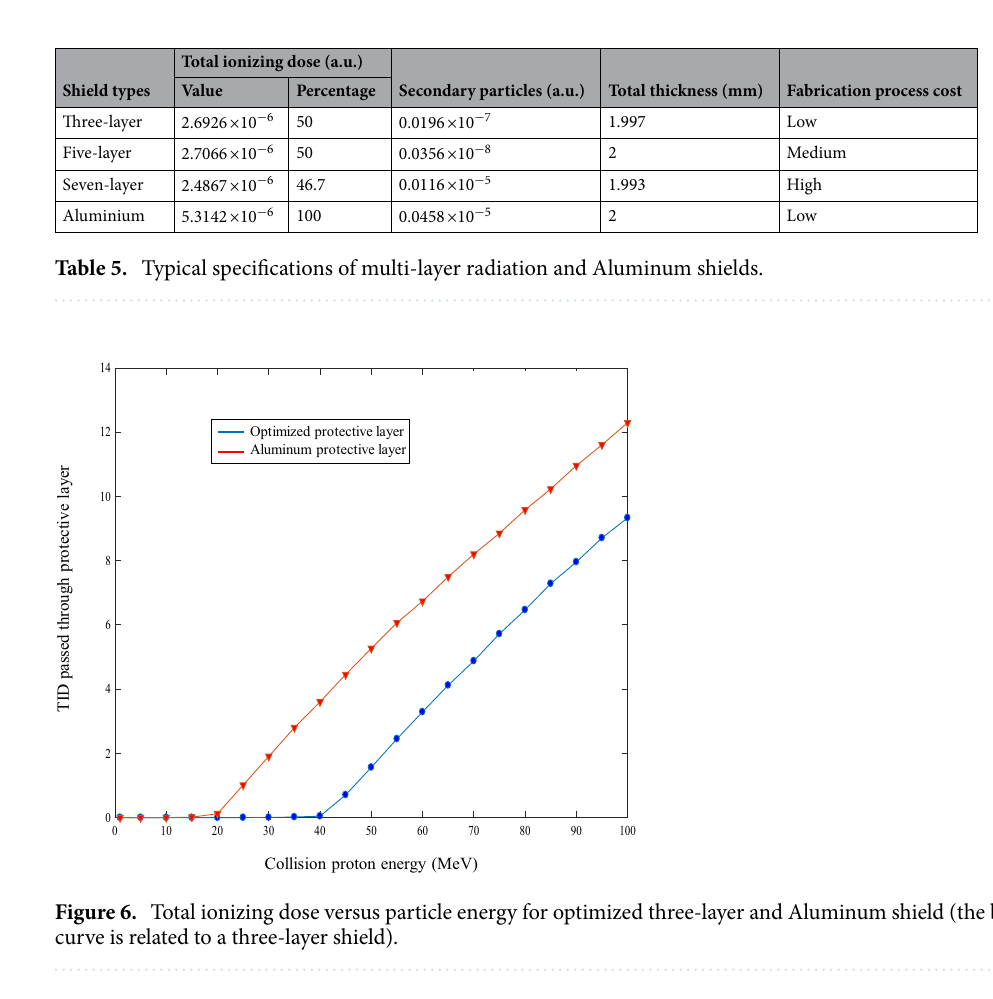
Figure 5. Convergence curve of GA for three-layer radiation shielding applied for proton space environments.